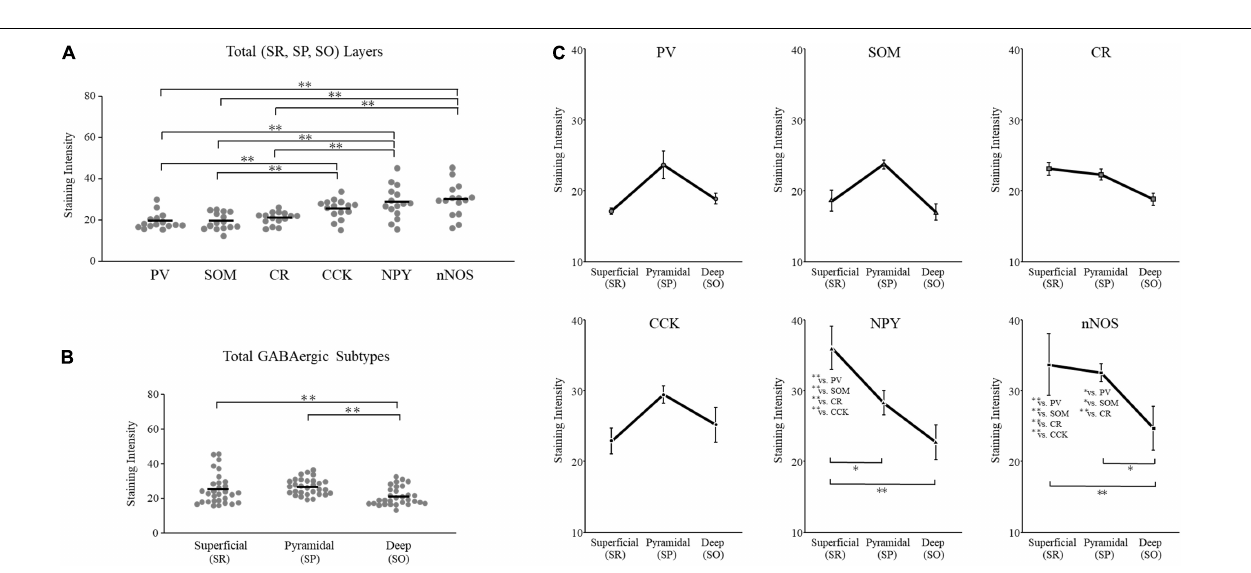
FIGURE 5 | GAD65 expression in each GABAergic subtype across layers of the hippocampus ( n = 5 brains). The average intensity of GAD65 immunostaining among six GABAergic subtypes (A) . The average intensity of GAD65 immunostaining among the superficial (SR), pyramidal (SP), and deep (SO) layers (B) . The average intensity of GAD65 immunostaining across layers of the cerebral cortex among six GABAergic subtypes (C) . SO, stratum oriens; SP, stratum pyramidale; and SR, stratum radiatum. Error bars indicate SEM. Two-way ANOVA followed by Bonferroni’s tests was used to compare the expression level. ∗ p < 0.05. ∗∗ p < 0.01.